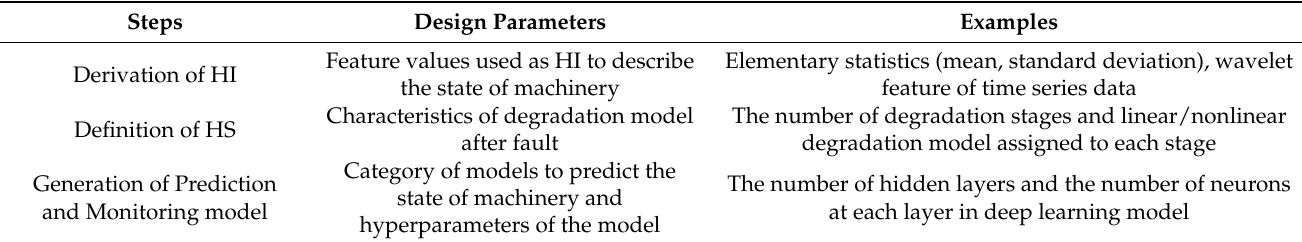
Table 1. List of design parameters in steps for developing a predictive maintenance model.